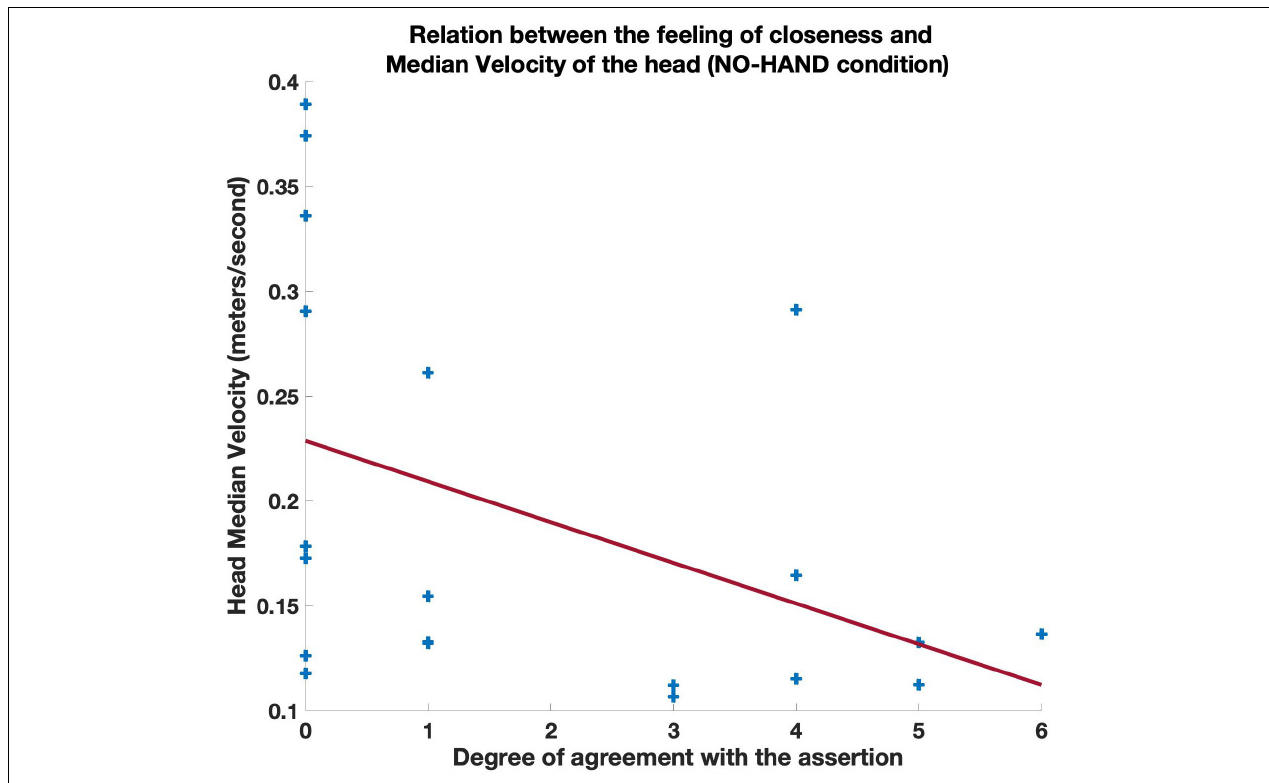
FIGURE 8 | Scatterplot of the relation between the responses to the question “ The absence of my own spheres made me feel more closeness with my partner ” and the Median Velocity of horizontal head displacements. 0 meant total disagreement and 6 total agreement with the assertion, with values in between corresponding to more moderate